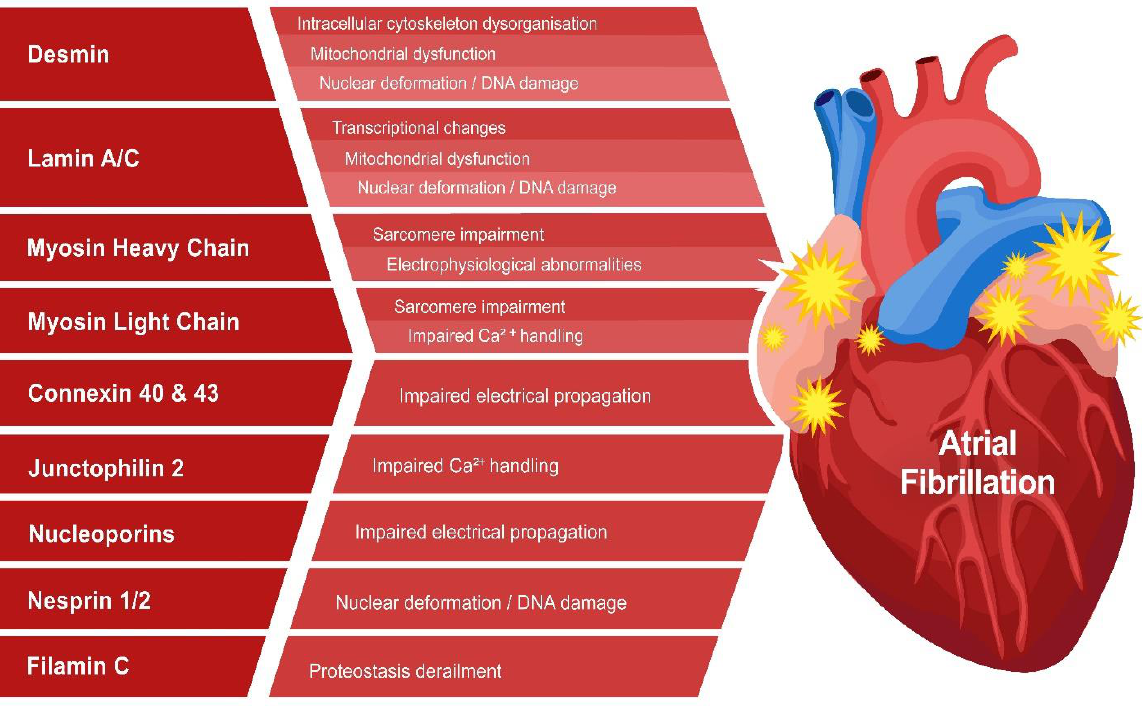
Figure 3. Overview of potential pathophysiological pathways of cytoskeletal (-associated) protein variants driving AF.